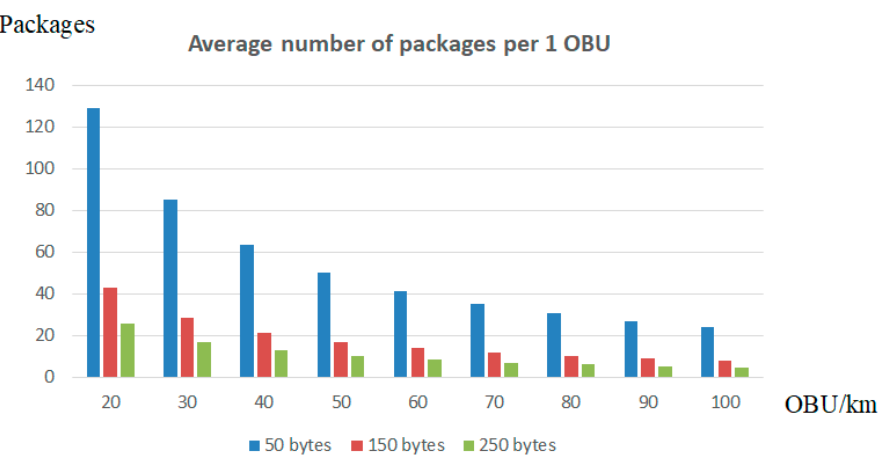
Figure 3. Dependence of the average number of packets per OBU on road traffic intensity with minimal level of confidentiality and a 32-bit protocol.